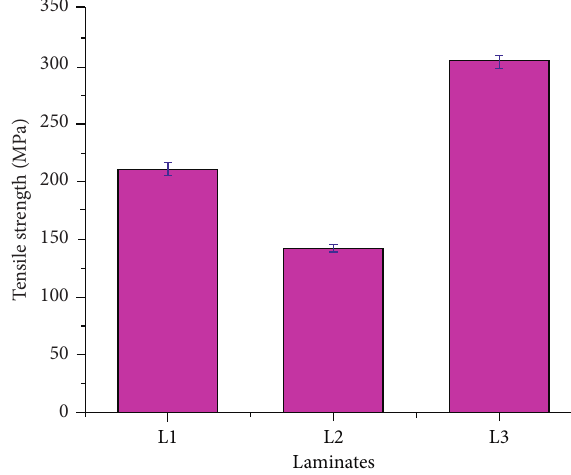
Figure 4: Representation of tensile strengths of different laminates.